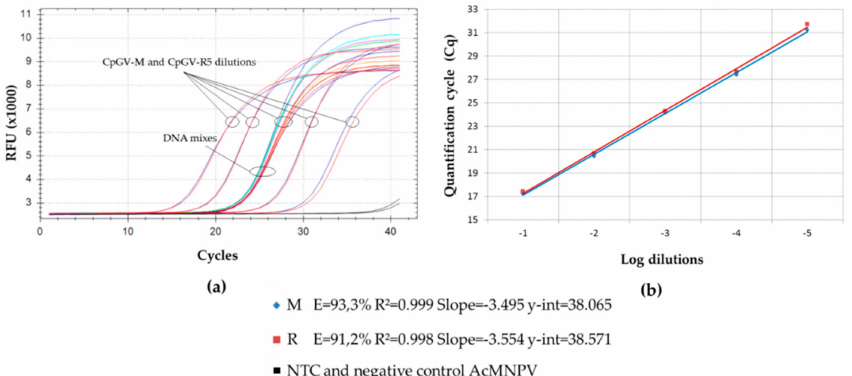
Figure 1. PCR amplification of CpGV pe38 gene for a range of dilutions of CpGV-M and CpGV-R5, and DNA mixes. ( a ) Relative fluorescence unit (RFU) upon PCR cycles. DNA mixes are encompassed by that of the reference virus dilutions tested. Amplifications from CpGV-M and CpGV-R5 are almost superposed for the whole range of dilutions tested. ( b ) Quantification cycle (Cq) depending on serial dilution for CpGV-M and CpGV-R5. E ffi cacy (E), correlation coe ffi cient (R 2 ), and y-intercept (y-int) are shown for pure CpGV-M and pure CpGV-R5.